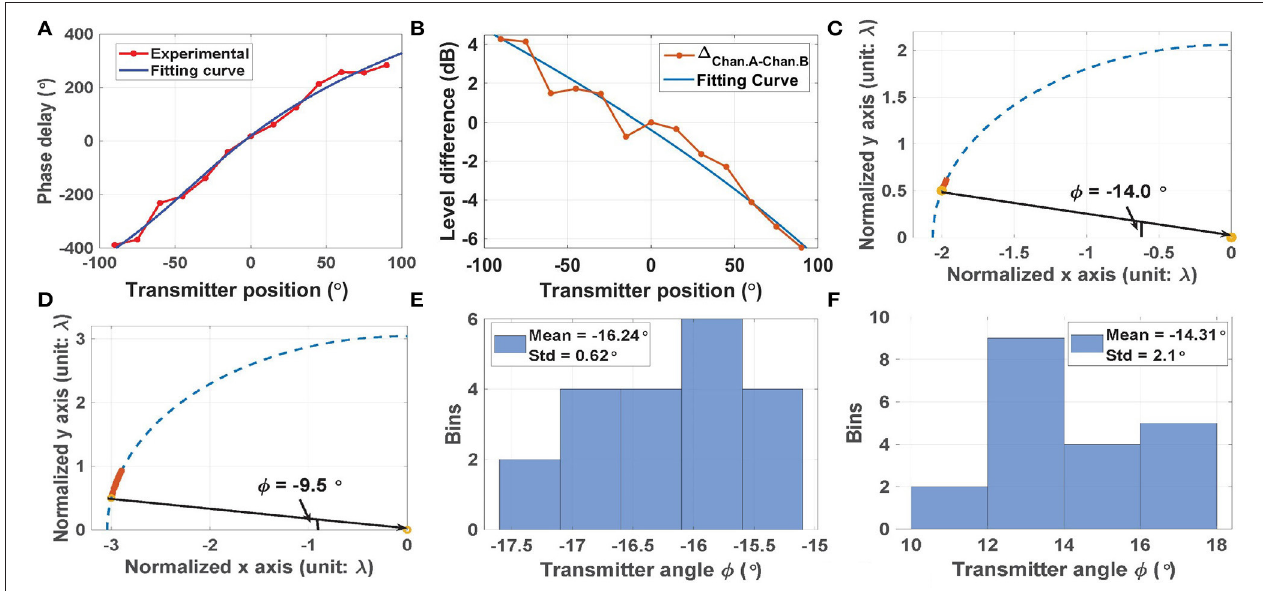
FIGURE 13 | (A) Experimental cochlear phase delay (i.e., ITD) and a polynomial fitting curve. (B) Experimental cochlear input power differences (i.e., ILD) and a polynomial fitting curve. Estimated transmitter positions using (C) ITD, and (D) ILD. In both cases, results from N = 20 trials are shown, and the actual transmitter position is indicated by the yellow circle. (E.F) Histograms of the position estimation error using (E) ITD, and (D) ILD.